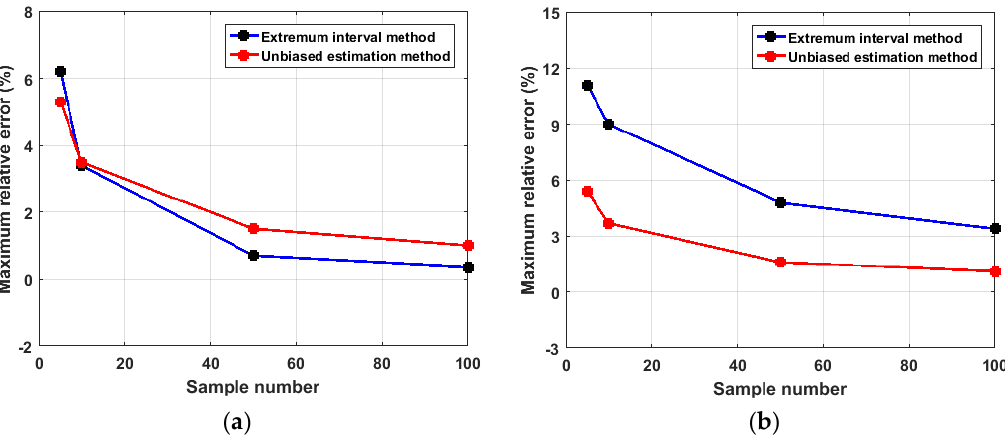
Figure 5. Maximum relative error of unbiased estimation method: ( a ) Uniformly distributed; ( b ) Normal distribution.